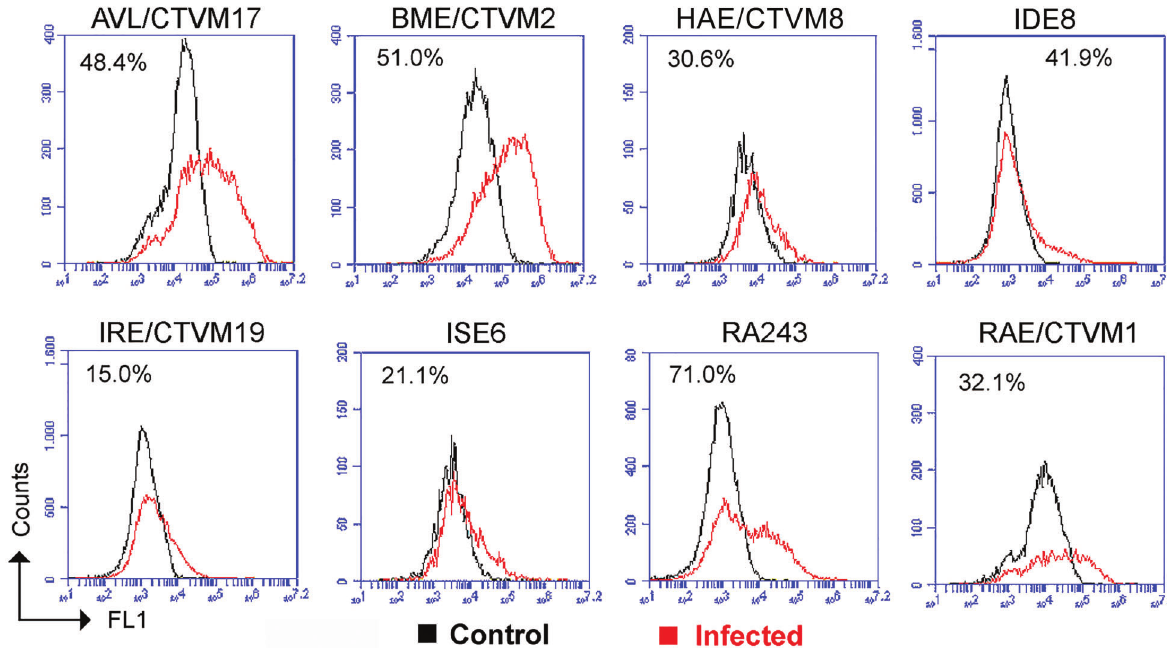
Figure 2. Percentage of tick cells with attached or internalized spirochetes as determined by fl ow cytometry. The tick cell lines AVL/CTVM17 (AVL17), BME/CTVM2 (BME2), HAE/CTVM8 (HAE8), IDE8, IRE/CTVM19 (IRE19), ISE6, RA243 and RAE/CTVM1 (RAE1) were inoculated with Borrelia burgdorferi , stained with PKH67, and cultivated in two different concentrations of medium, namely 10% BSK-H medium + 90% tick cell medium and 90% BSK-H medium + 10% tick cell medium. Data are reported as mean ± SD. There were no signi fi cant differences (*P 4 0.05) for the IRE19, ISE6 and RAE1 cell lines between the two combinations of culture media